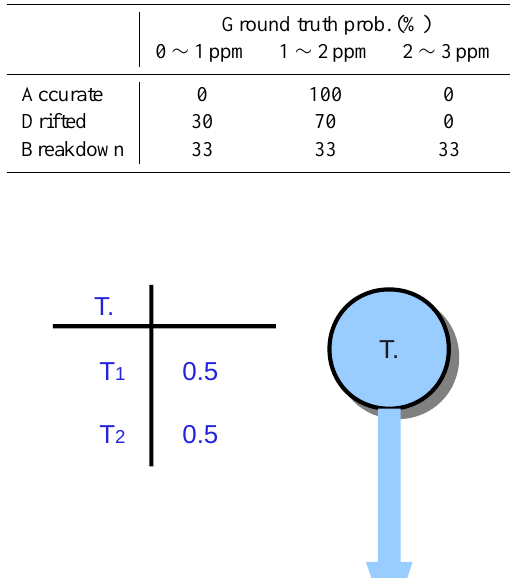
Table 1. An example error distribution with reported reading of